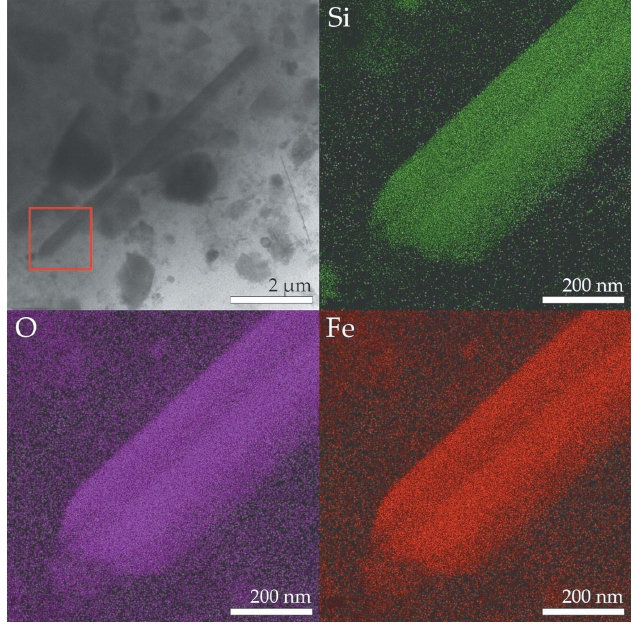
Figure 3 A STEM image of an uncoated amosite fibre with the chemical mapping showing its characteristic chemical elements (Si, Fe and O) with the corresponding STEM-EDX maps. The red square indicates the area selected to carry out the EDX mapping.